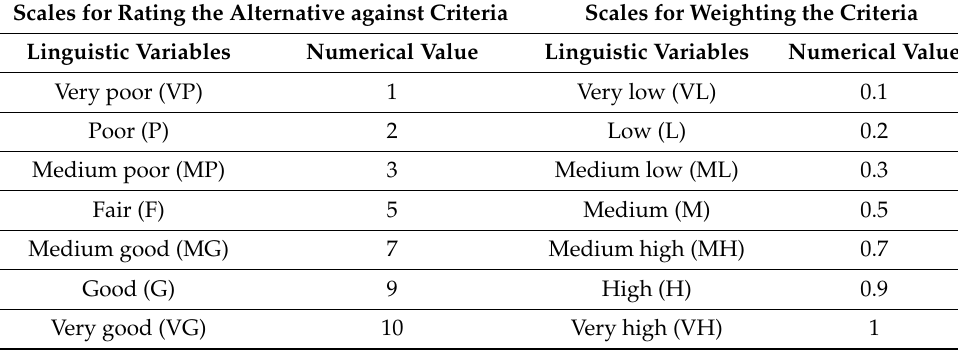
Table 5. Linguistic variables for rating and weighting of criteria.